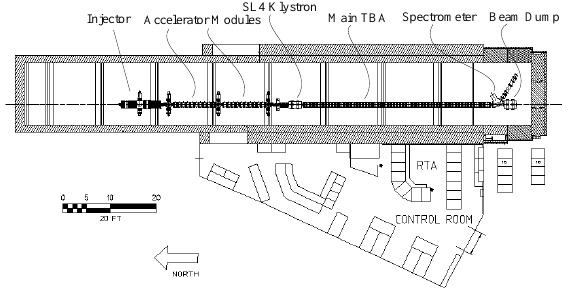
FIG. 1. RTA experiment